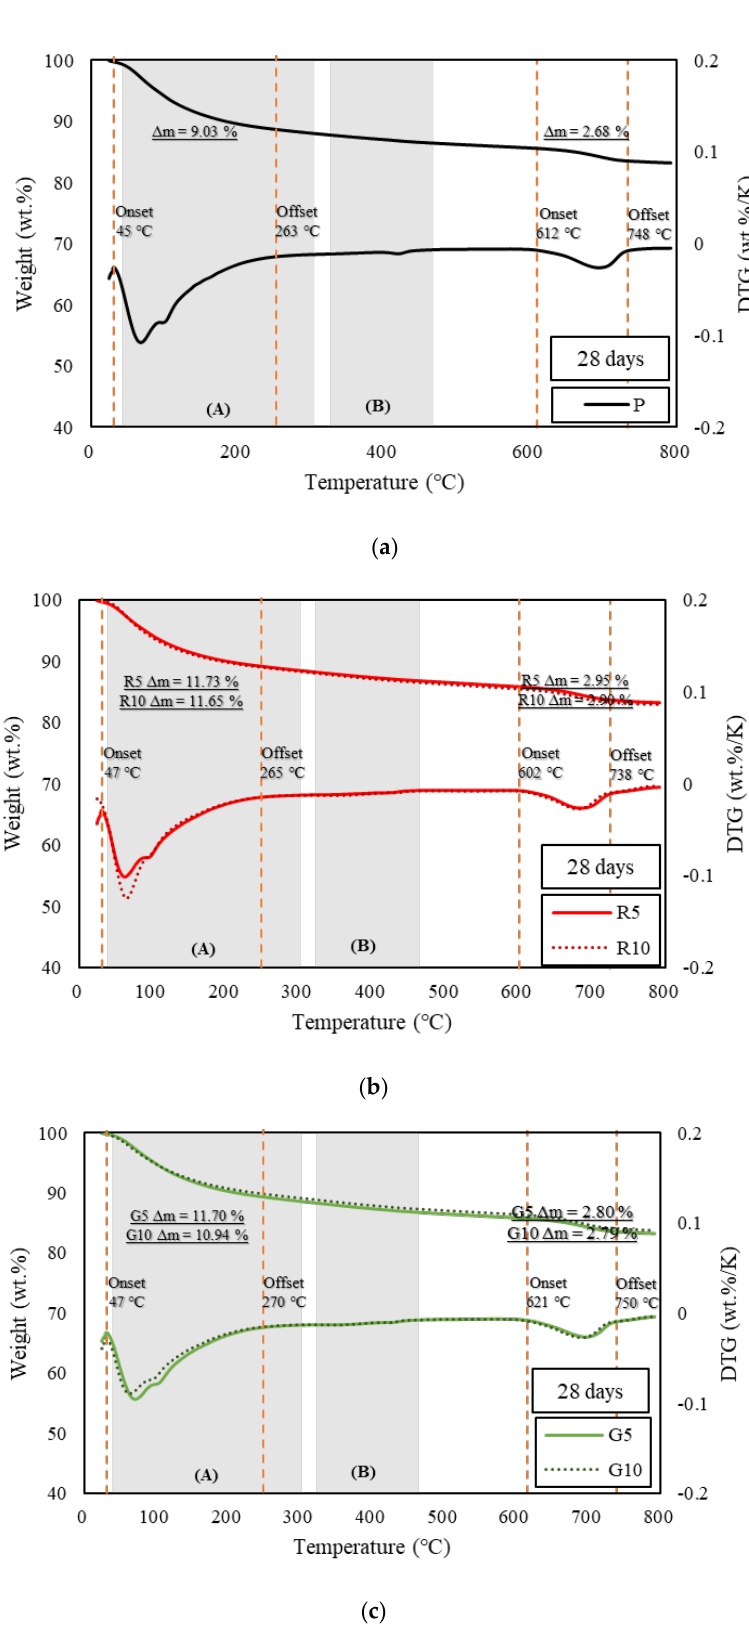
Figure 4. TGA of samples at seven days. ( a ) TGA results of specimen P at the age of seven days, ( b ) TGA results of specimens R5 and R10 at the age of seven days, and ( c ) TGA results of specimens GR5 and G10 at the age of seven days.